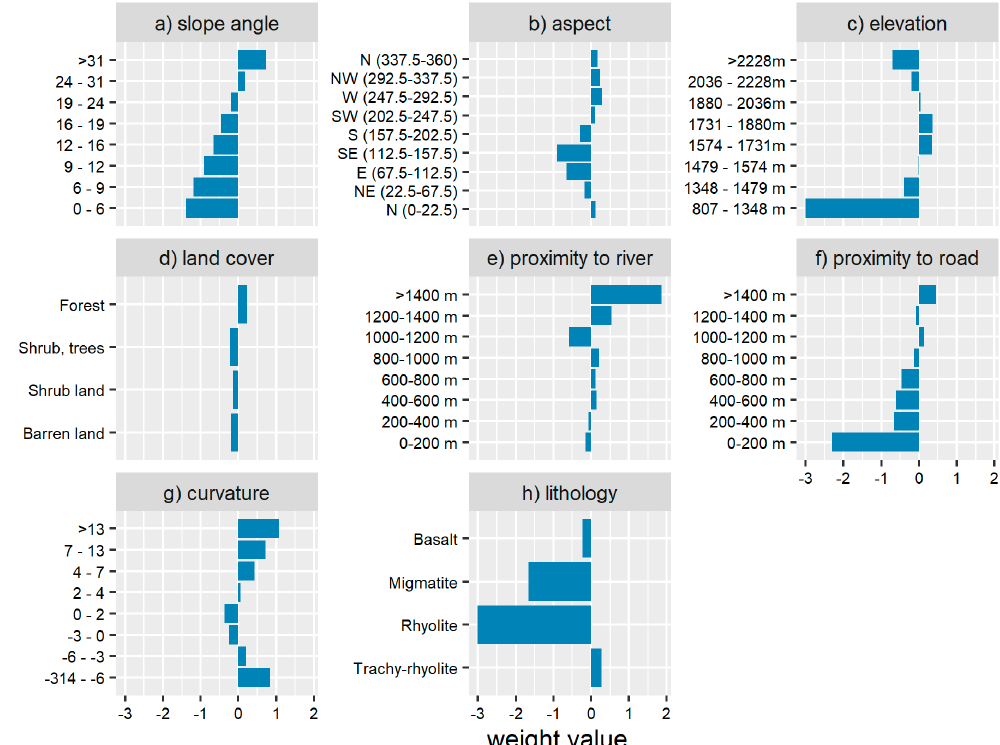
Figure 9. Geo-environmental factors with their corresponding classes and weights: Negative weight means the class parameter has less influence on landslide events and positive weight values show that the class parameter has a significant effect on landslides in this area.